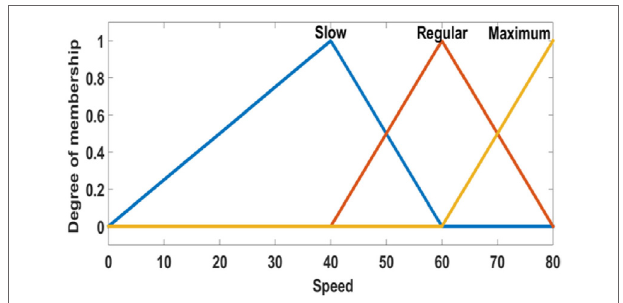
FigUre 5 | Membership functions of speed.